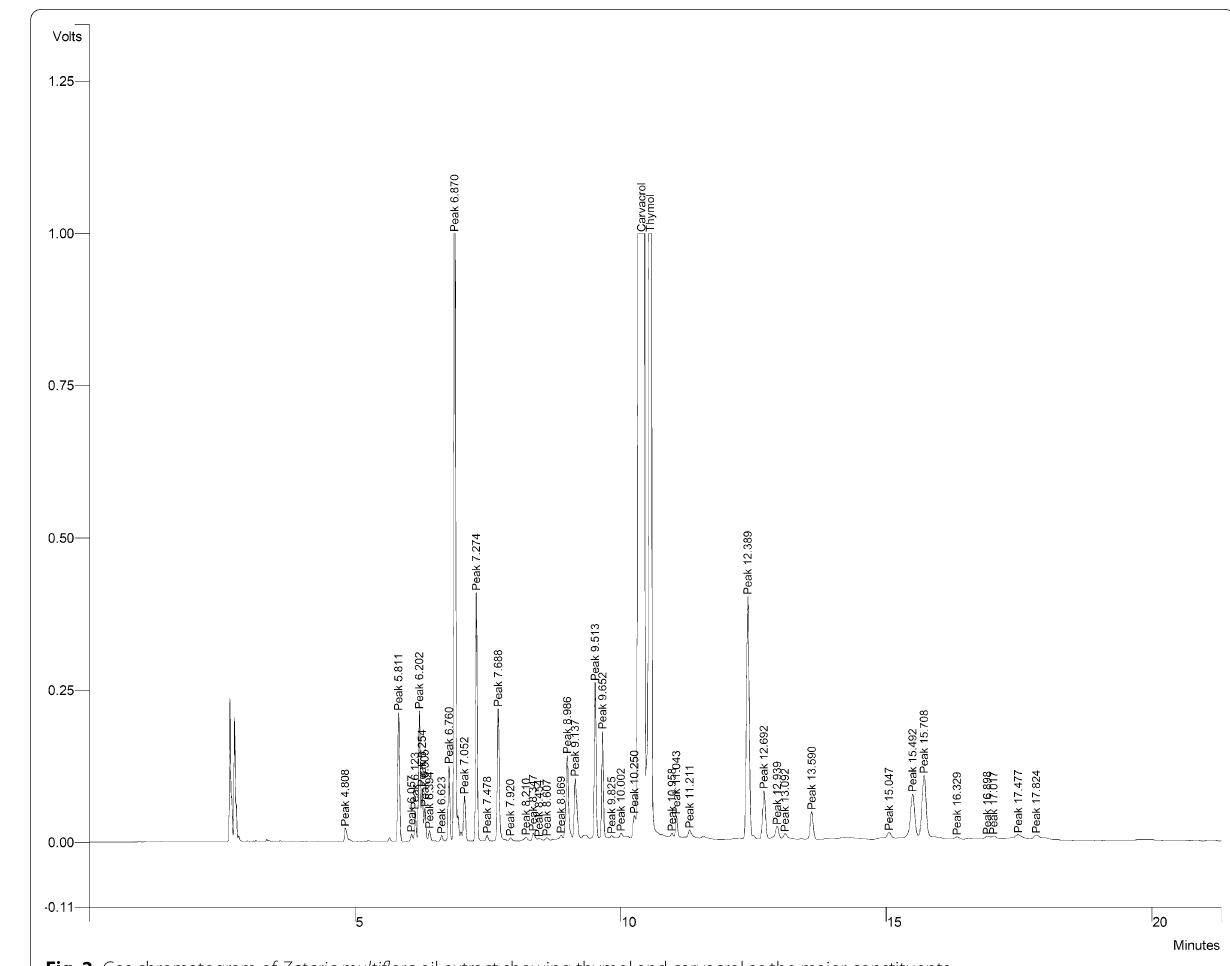
Table 2 MIC, MBC, and MFC of Echinacea, Arctium, and Zataria